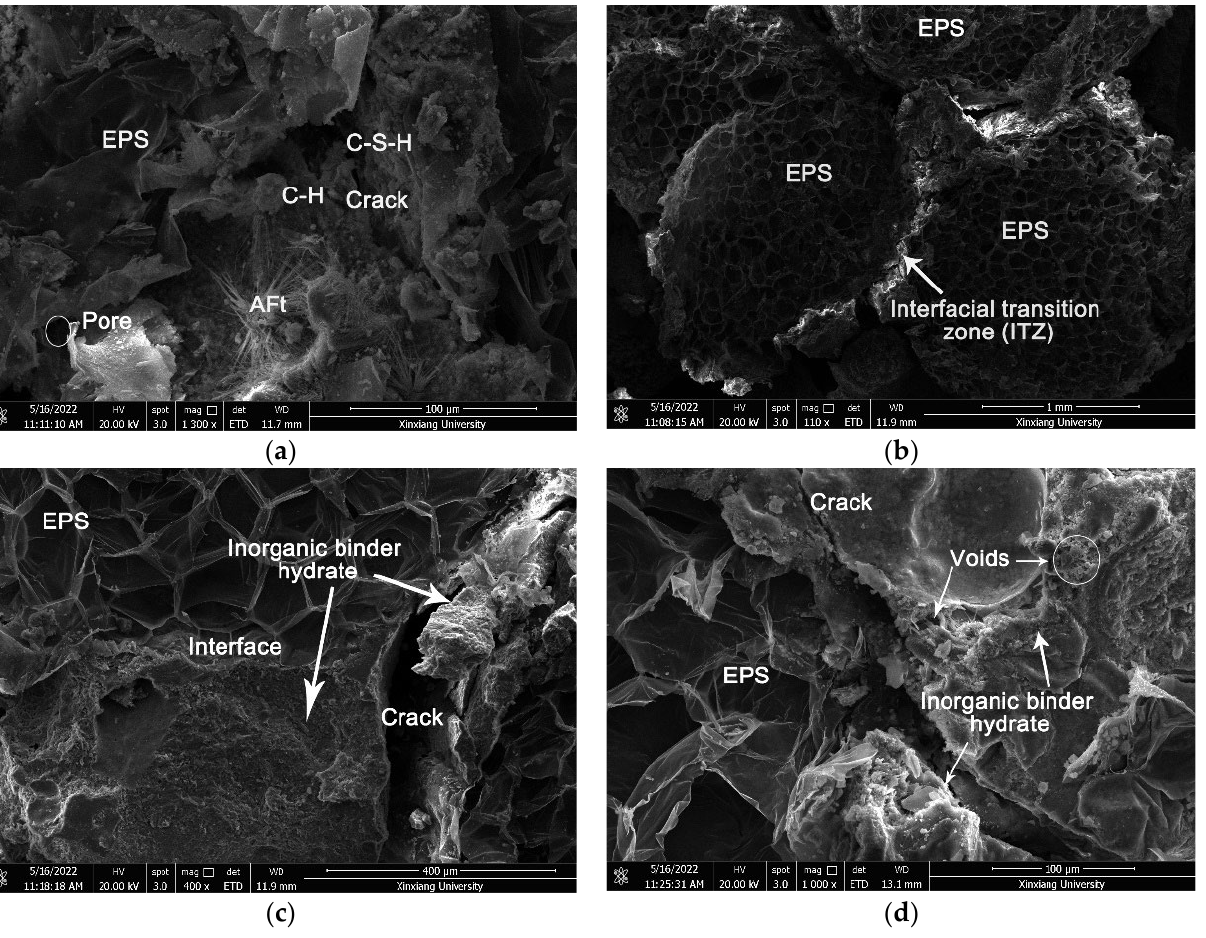
Figure 11. The microstructures of the CEPS: ( a ) the cement-based binder after hydration, ( b ) ITZ, ( c ) crack, and ( d ) voids and crack.